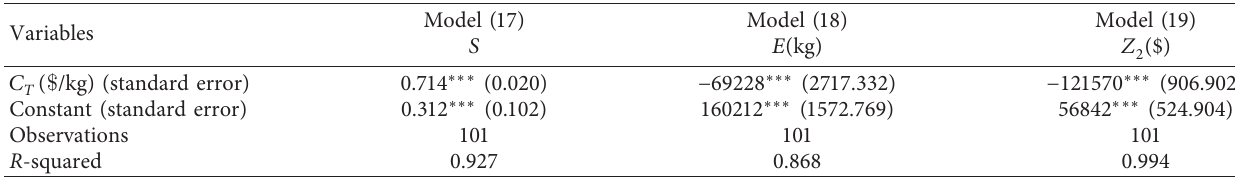
Table 5: Regression results under carbon tax regulation.